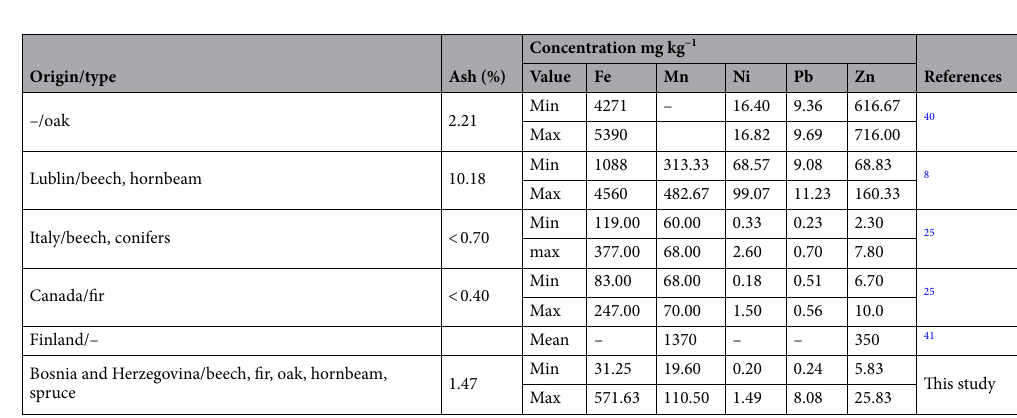
Table 5. Comparison of obtained values of heavy metals (Fe, Mn, Ni, Pb, and Zn) in analyzed pellets with similar studies.